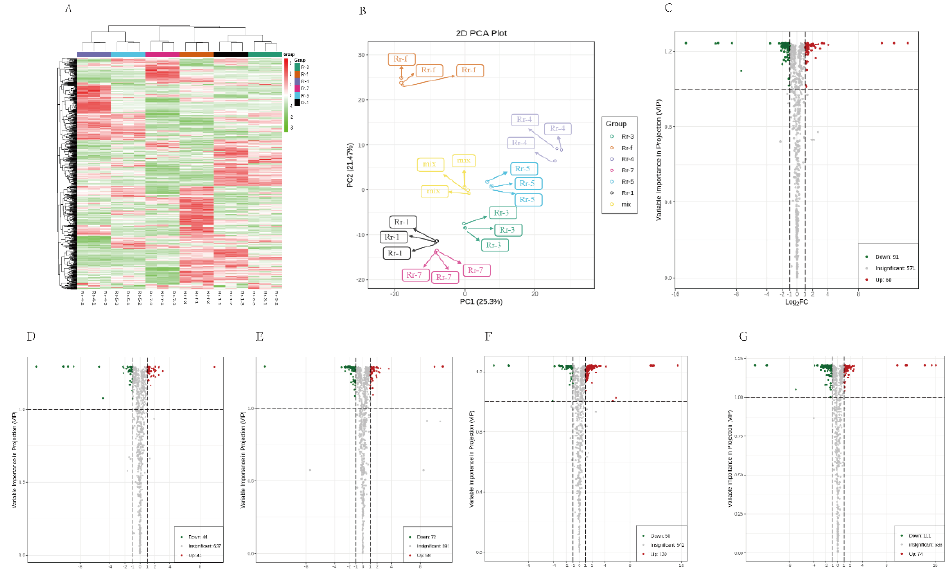
Figure 3. ( A , B ) Heat map and PCA of the relative quantification in the detected metabolites among the six R. roxburghii genotypes. ( A ) Heatmap for six genotypes. The metabolites of all types were normalized to complete the hierarchical linkage clustering. Red indicates high abundance, green indicates relatively low metabolite abundance. ( B ) Differential metabolites of six genotypes based on PCA. ( C – G ) Volcano plots showing up-regulated and down-regulated metabolites between pairs of samples from different genotypes. ( C ) Rr-1 vs. Rr-5. ( D ) Rr-3 vs. Rr-5. ( E ) Rr-4 vs. Rr-5. ( F ) Rr-7 vs. Rr-5. ( G ) Rr-f vs. Rr-5.